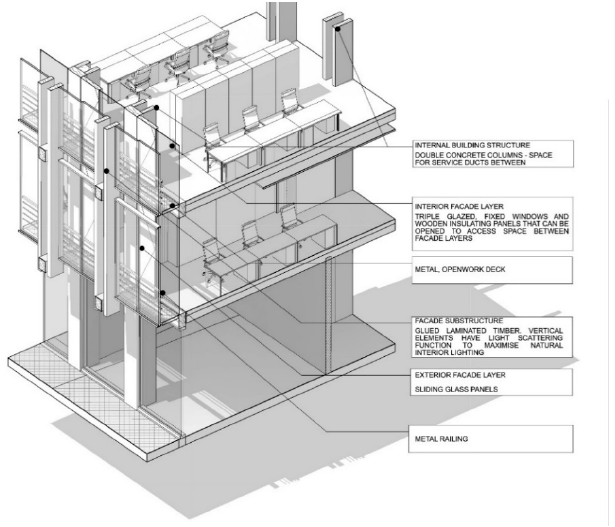
Figure 7. A 3D cross section through the double skin elevation proposed on south and west elevations. Energies 2020 , 13 , x FOR PEER REVIEW